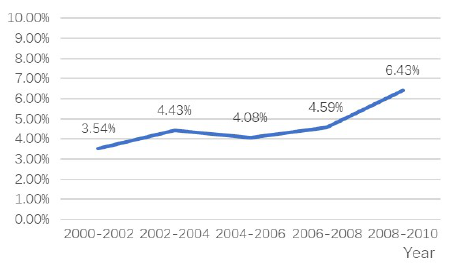
Figure 6 . Urban built-up area expansion speed index in Yangtze River Delta urban agglomeration.